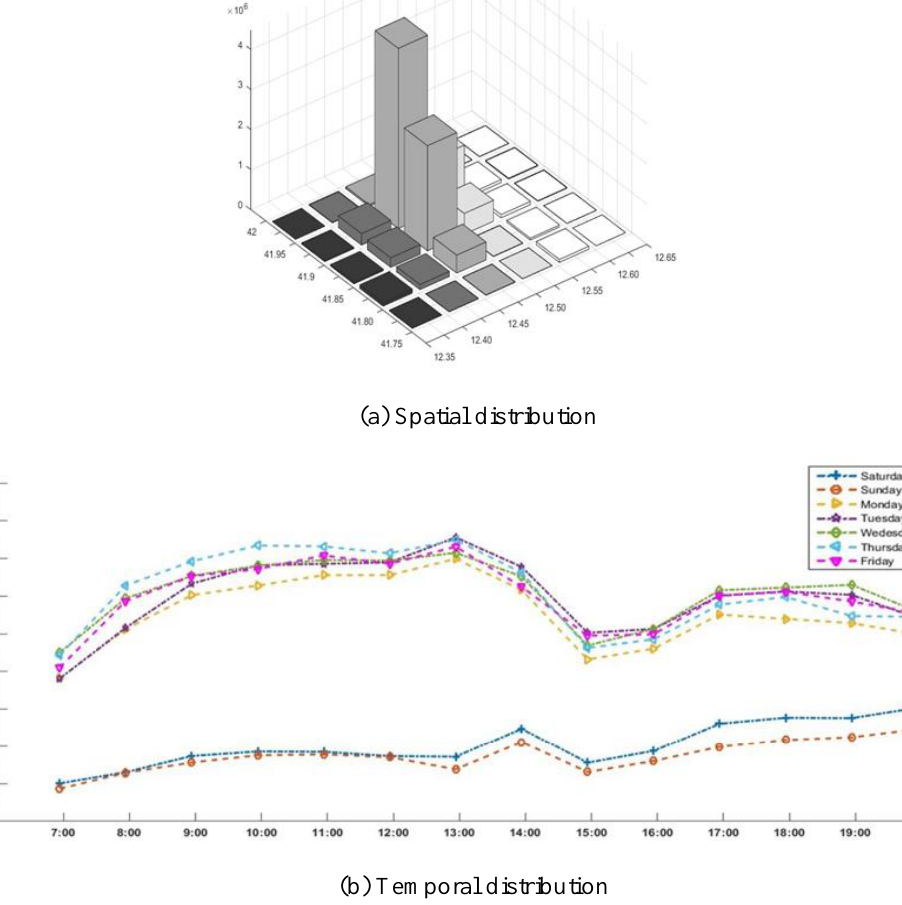
Figure 4. Spatial and temporal distribution of the